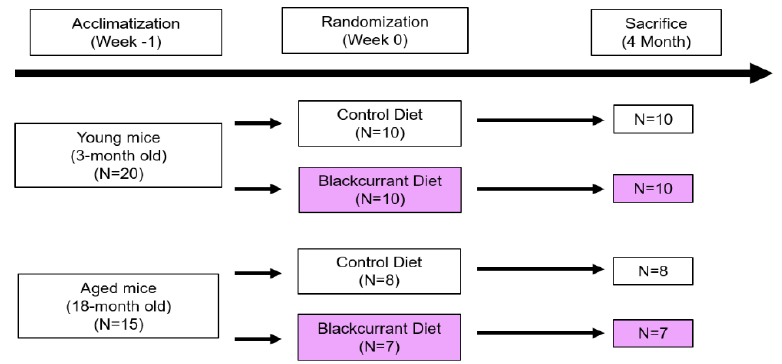
Figure 1. Experimental design.